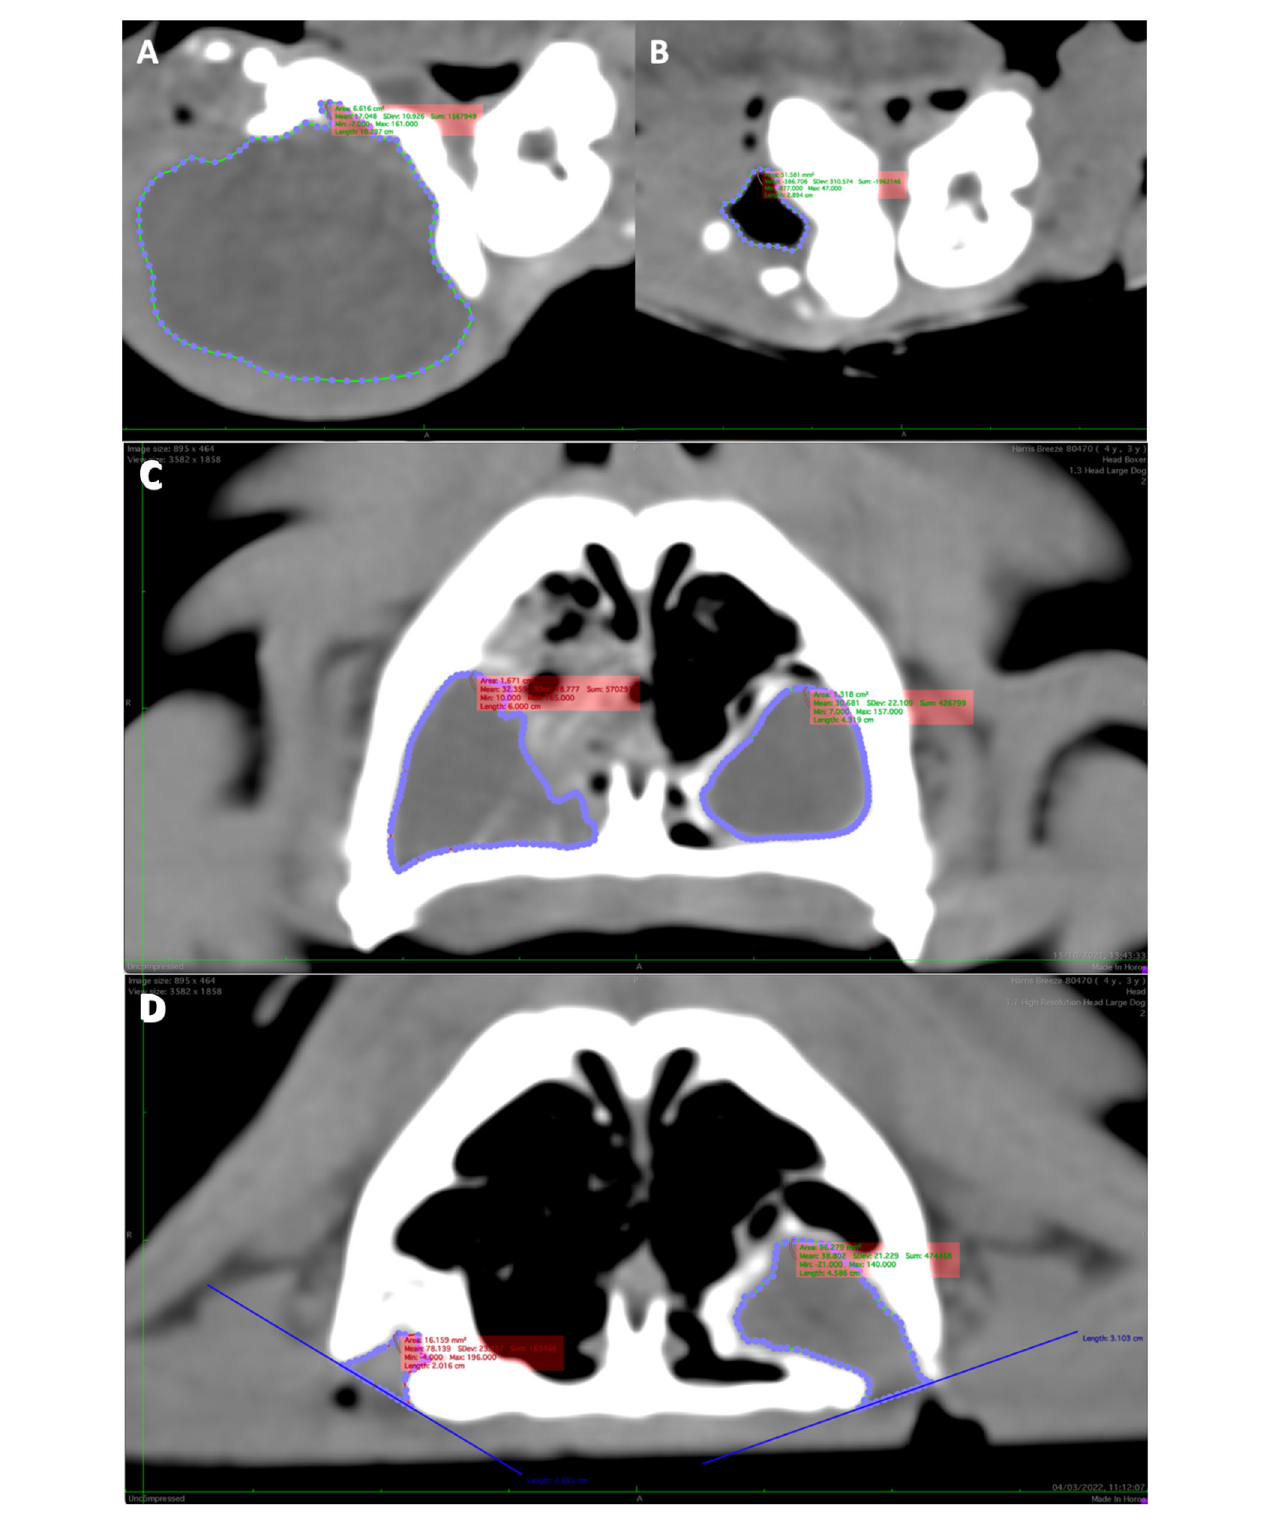
FIGURE2 Reconstructed transverse CT scan demonstrating Region of interest (ROI) of a large right mandibular dentigerous cyst in Case 1 at time of presentation (A) and 92 days post-operatively showing a large reduction in cyst volume (B) . (C) The ROIs of two large cysts in the left and right maxilla of Case 5 and 141 days post-operatively (D) . Note the difference reduction in volume between the left and right cysts. (D) Also shows how the ROI was created in the location of the marsupialisation by drawing a straight line between the bone edges and using this as a